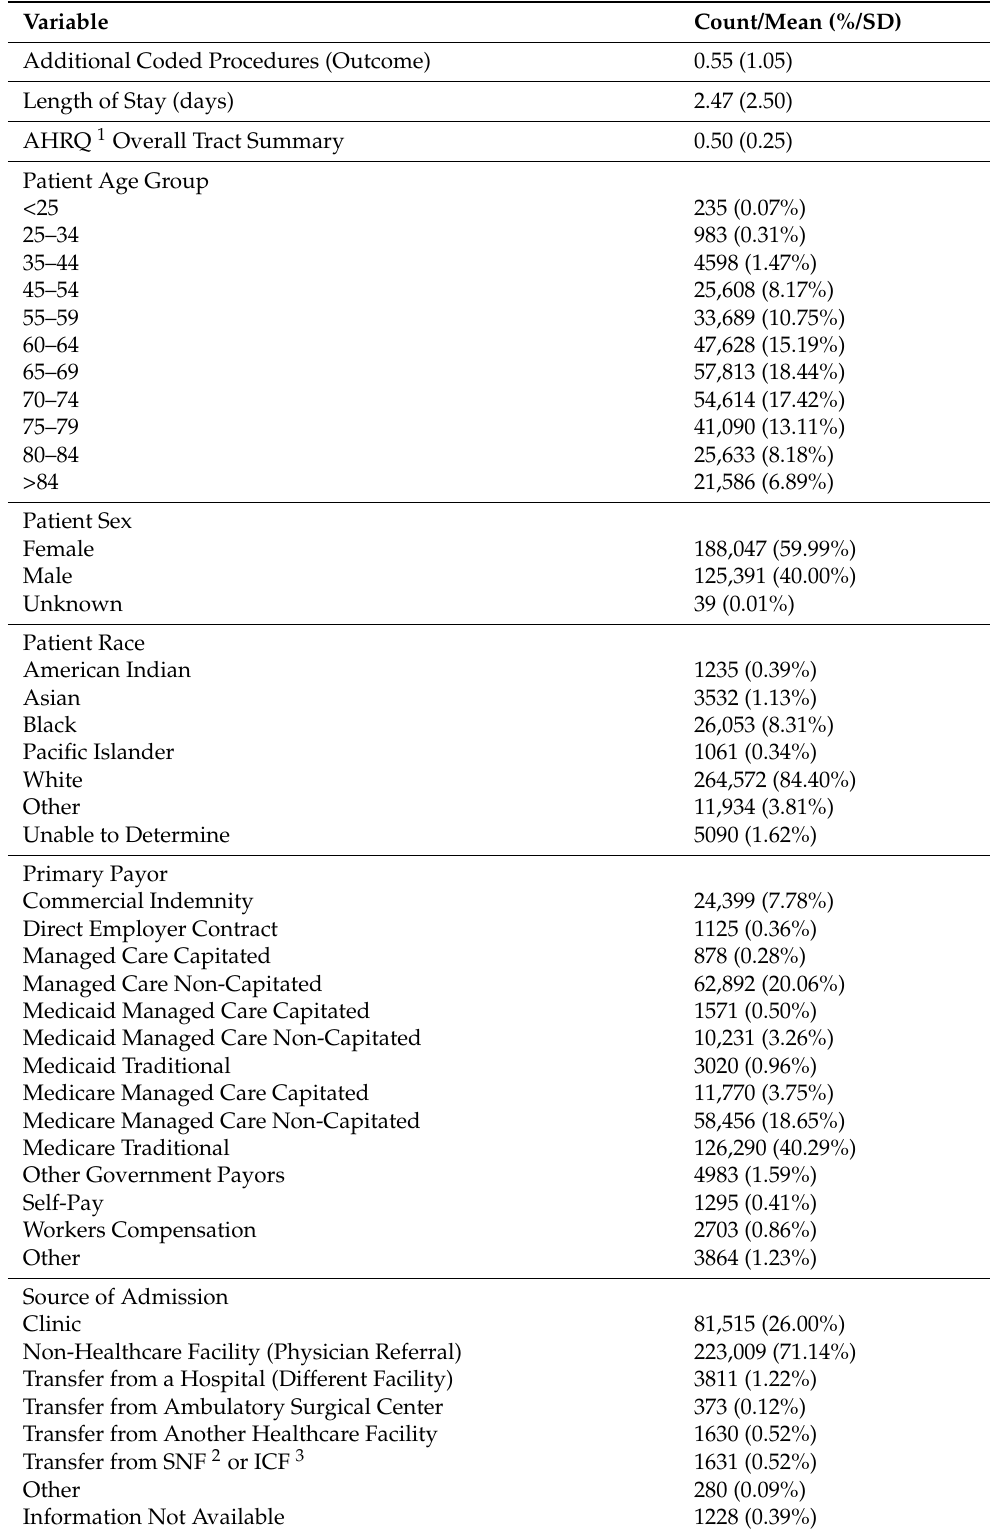
Table 1. Descriptive statistics (count/mean and percentage/standard deviation, respectively) of patient characteristics, facility characteristics, and the outcome (additional coded procedures) for n = 313,477 unique patient